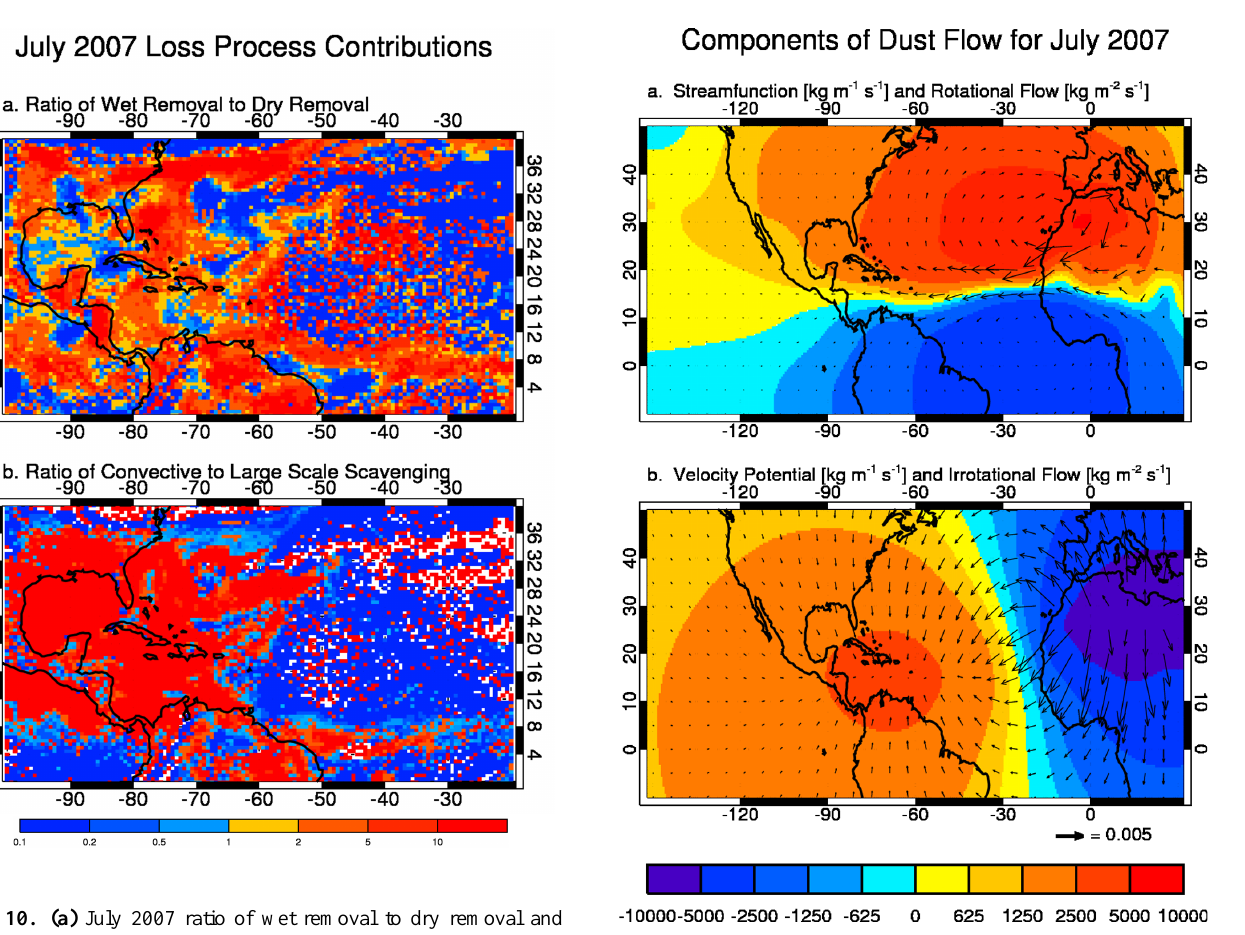
Fig. 11. July 2007 mean streamfunction (a) and velocity potential (b) . Rotational (top) and irrotational (bottom) flows are indicated by